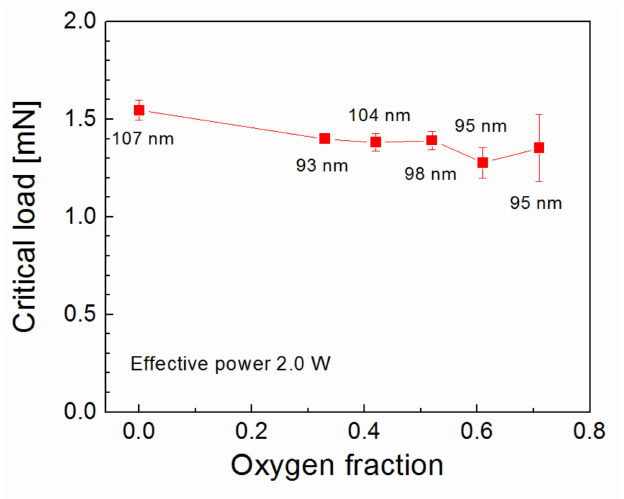
Figure 9. Critical load as a function of oxygen fraction for plasma nanocoatings deposited on silicon wafers from TVS / O 2 mixture. Nanocoating thickness is given.